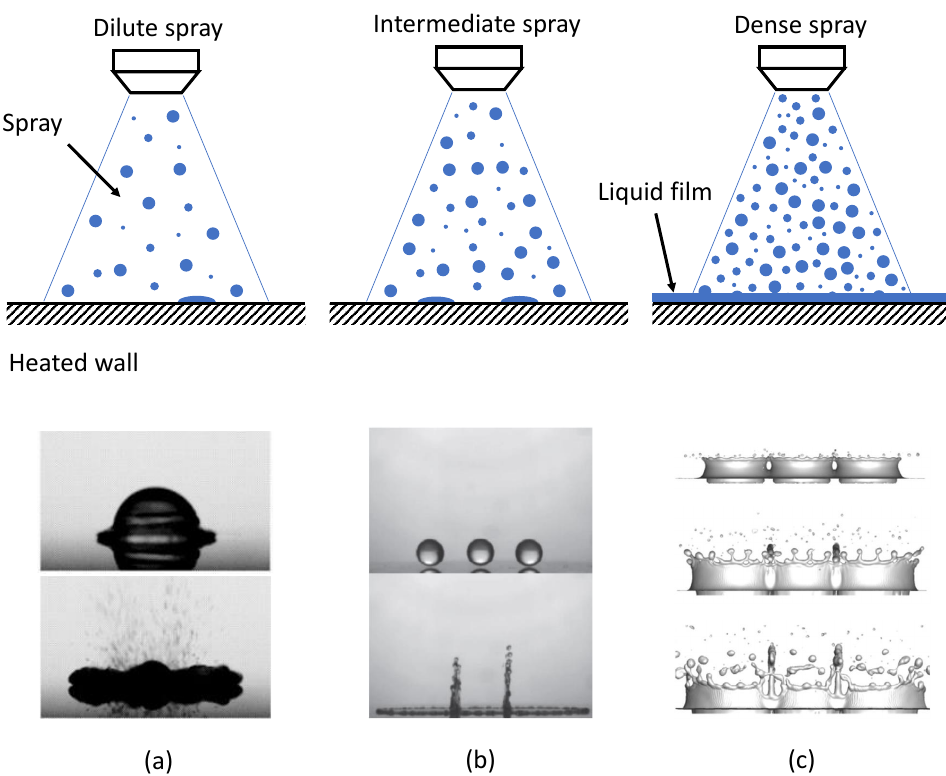
Figure 11. Schematics of sprays corresponding to different volumetric fluxes, and associated images capturing interactions between droplets and solid surface or liquid film: ( a ) dilute spray, ( b ) inter- mediate spray, and ( c ) dense spray [170]. Adapted from [170–172], Copyrights (2016, 2017, 2018), with permission from